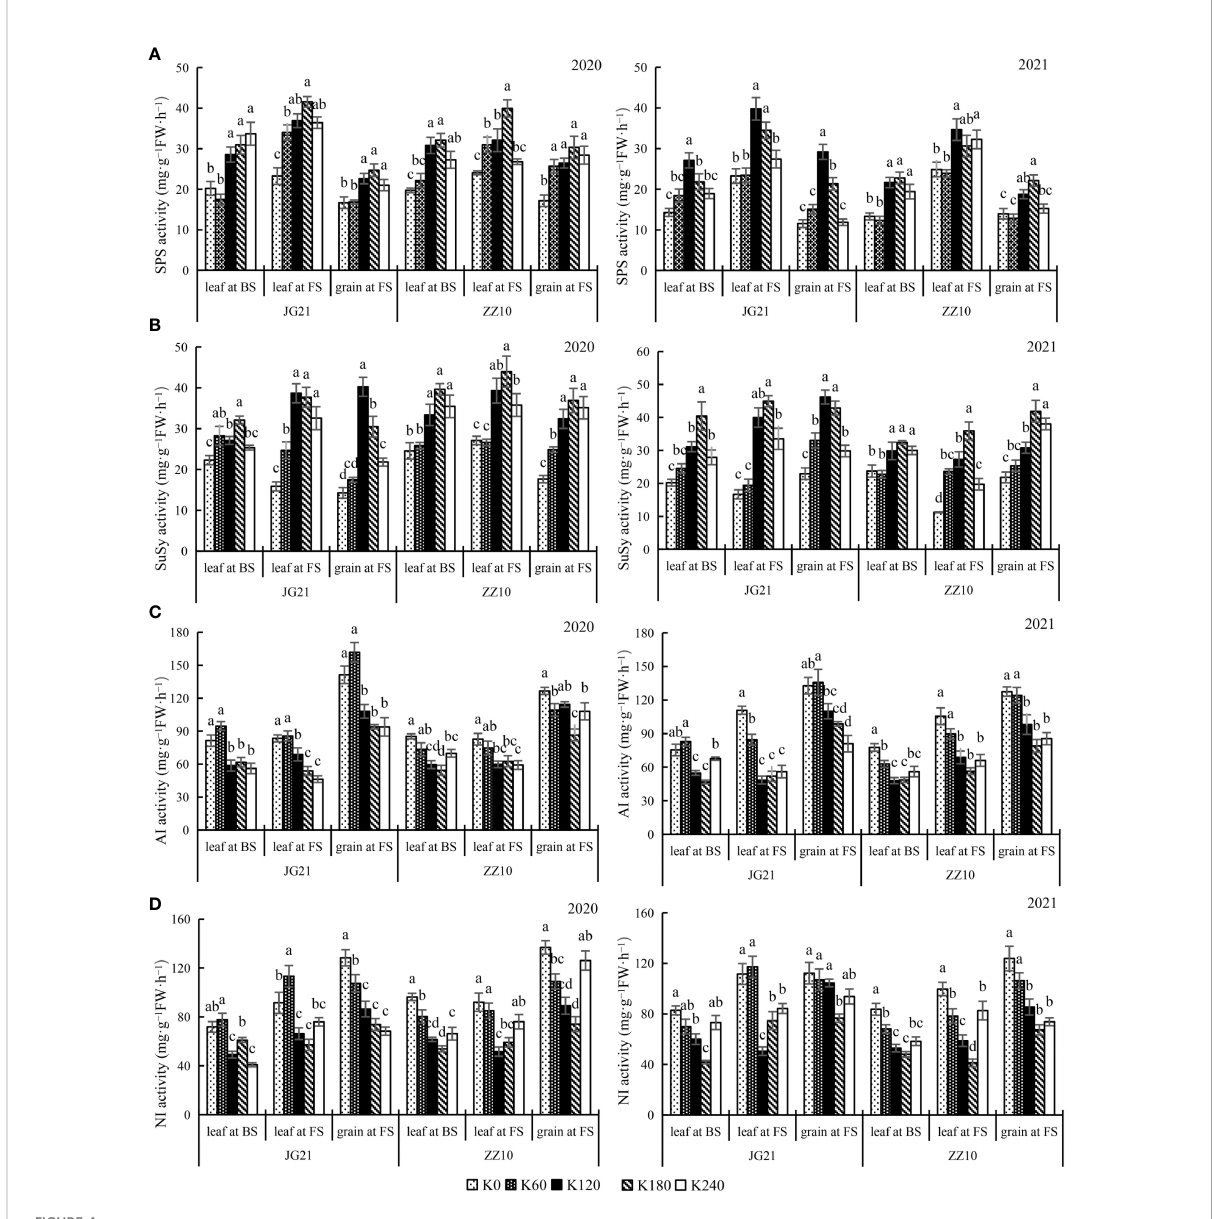
FIGURE 4 Effects of potassium application rate on sucrose metabolism-related enzyme activities of foxtail millet cultivars, Jingu 21 (JG21) and Zhangza 10 (ZZ10). Potassium applications include 5 level 0 (K 0 ) as control, 60 (K 60 ), 120 (K 120 ), 180 (K 180 ), and 240 (K 240 ) kg·hm − 2 of K 2 O. BS: booting stage, FS: fi lling stage. The different normal letters indicate signi fi cant differences in different treatments of the same variety at the 0.05 level. Values are means ± SE (n = 3). (A) SPS, sucrose phosphate synthase. (B) SuSy, sucrose synthase. (C) AI, Acid invertase. (D) NI, neutral